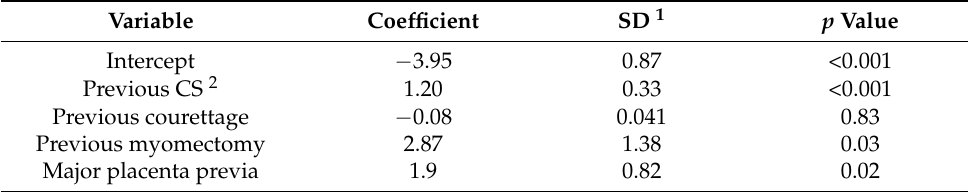
Table 2. Results of the logistics model.